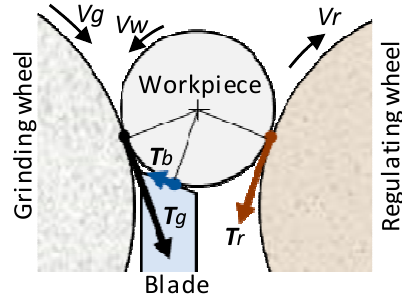
Figure 4. Torques acting on workpiece during centerless grinding.